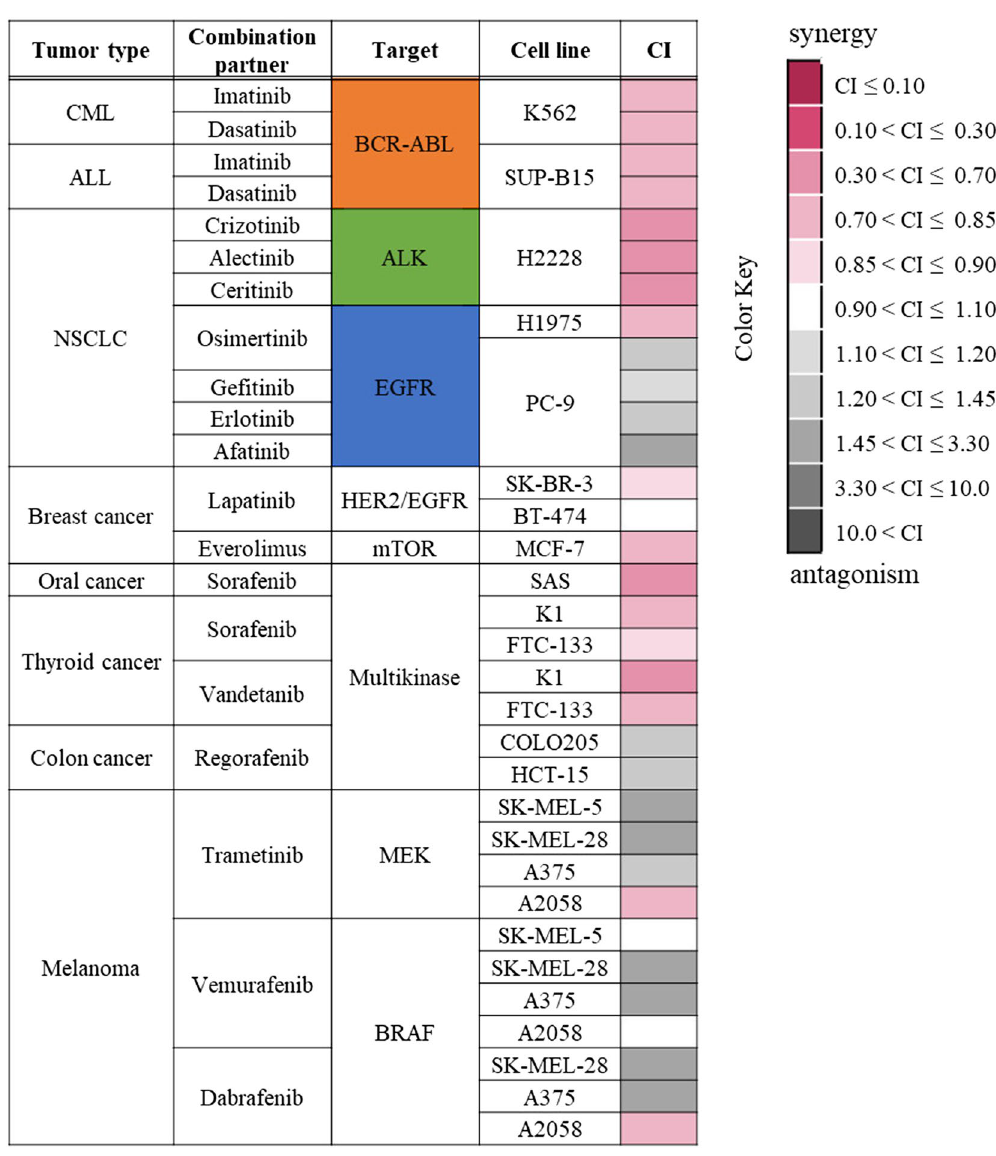
combination index (CI) method. The antiproliferative effect of YHO-1701 and/or molecular-targeted agents was evaluated in a human cancer cell line panel using the WST-8 assay at 48 or 72 h of exposure. CI values were calculated and represented as a synergy “heat map” where a drug combination is synergistic (pink color) if CI ≤ 0.9; additive (white color) if CI is 0.9–1.1; and antagonistic (gray color) if CI >